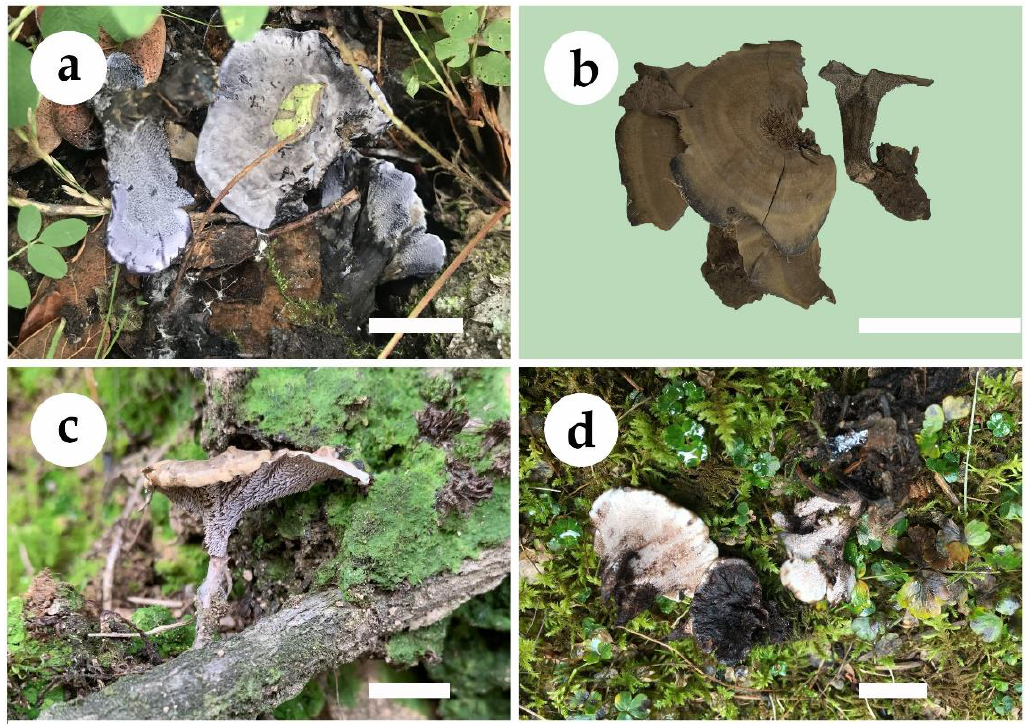
Figure 3. Basidiomata of Phellodon species. ( a ) P. caesius , ( b ) P. concentricus , ( c ) P. henanensis , and ( d ) P. subgriseofuscus . Scale bars: 2 cm.